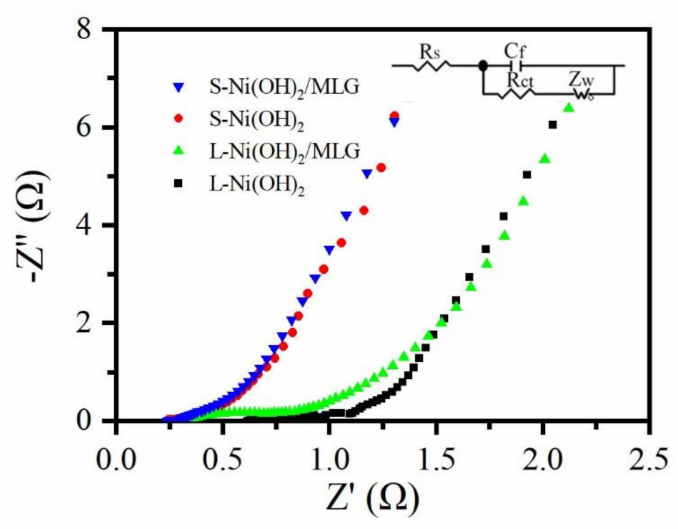
Figure 7. Nyquist plots of S-Ni(OH) 2 /MLG, L-Ni(OH) 2 /MLG, S-Ni(OH) 2 and L-Ni(OH) 2 , the inset shows the equivalent circuit diagram.